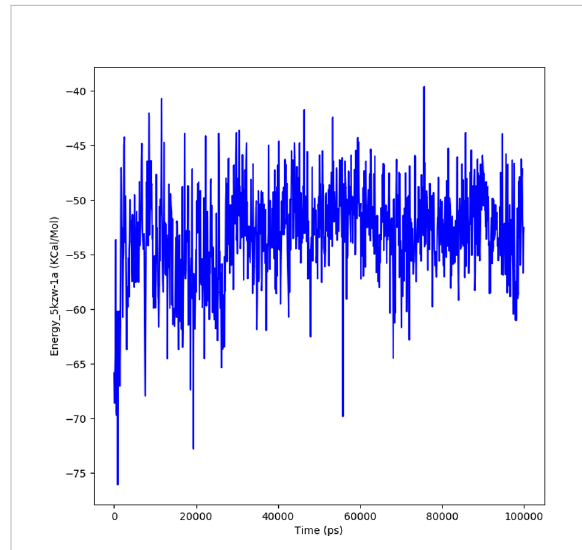
FIGURE 8 The plot illustrating the interaction in the form of free energies of binding between protein-ligand